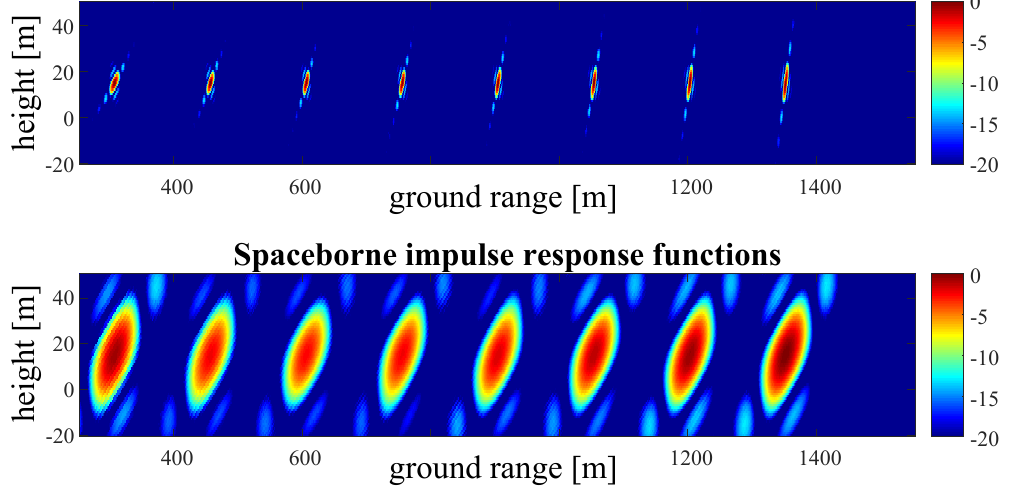
Figure 5. Impulse response functions (IRFs) in the zero-Doppler plane varying the distance from the radar. The IRFs of the airborne system changes significantly (mainly its rotation) from near to far range whereas the spaceborne system is almost constant. The horizontal and vertical axes refers to the ground range ( y ) and elevation ( z ) axes shown in Figure 1 respectively. The height is here referred to a constant elevation taken as a